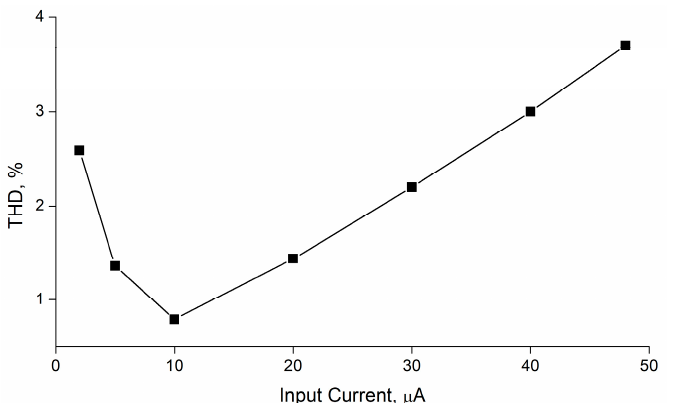
Figure 8. THD values of output voltages of the proposed simulated inductor for different peak values of the input currents.